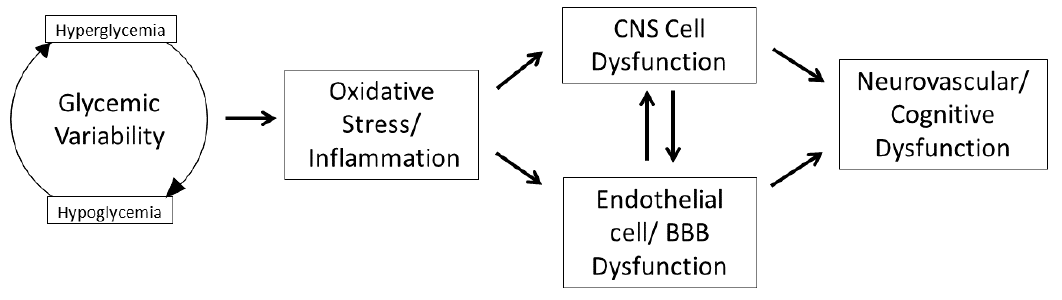
Figure 1. The impact of glycemic variability in the central nervous system.